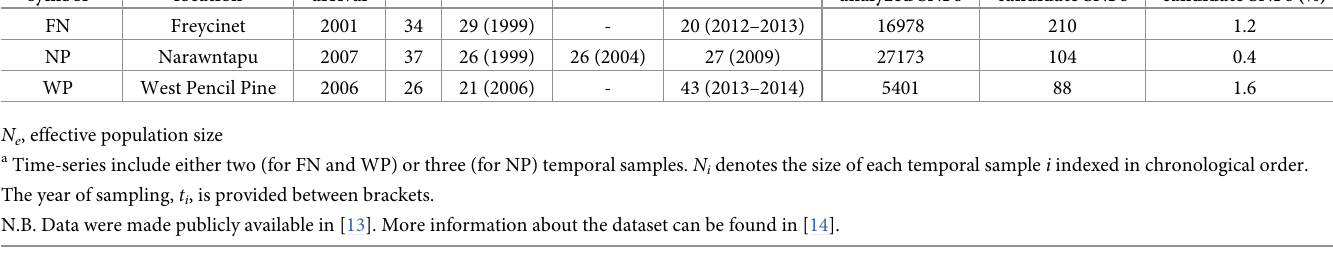
Table 1. Genomic time-series investigated to identify signatures of selection in the Tasmanian devil ( Sarcophilusharrisii ). Population symbol